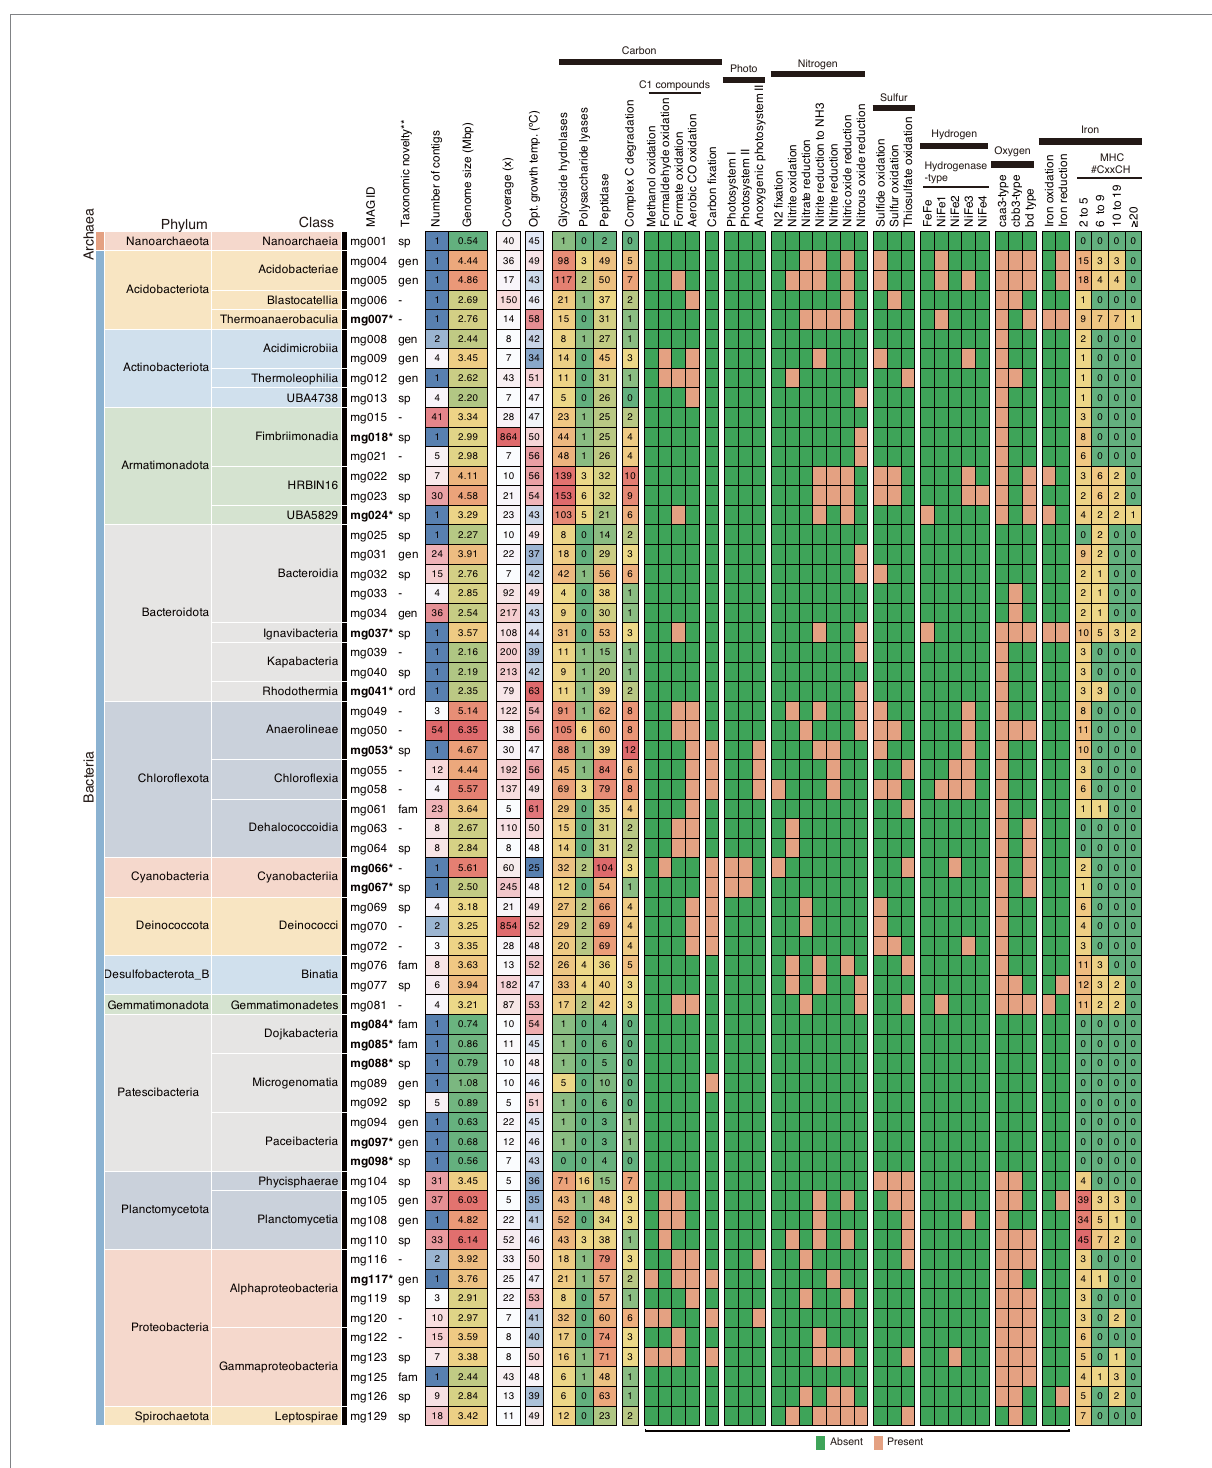
FIGURE 2 Summary of general feature and metabolic potential for the 61 HQ MAGs. Taxonomy, number of contigs, genome size, coverage, estimated optimum growth temp, and gene context for main metabolism are shown. *IDs of cMAGs are in bold. **Taxonomic novelty: the novelty of taxonomic ranks of our MAGs against the latest GTDB R207: ord, order level; fam, family level; gen, genus level; species